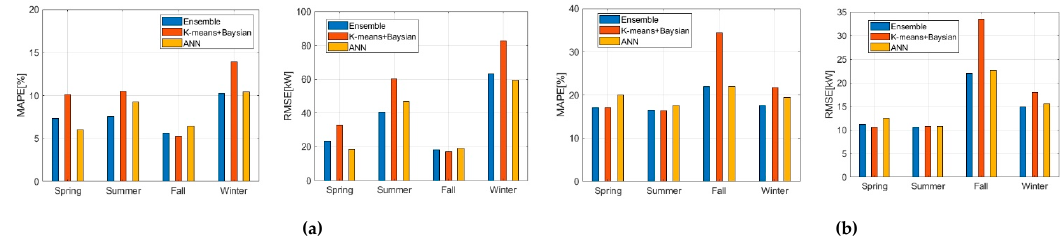
Figure 17. KEPCO substation stochastic demand forecast. ( a ) Spring, ( b ) Summer, ( c ) Fall, ( d ) Winter.